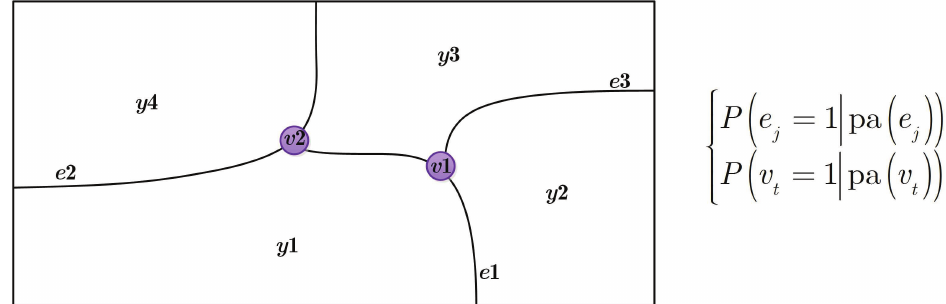
Figure 6. The causalities among regions, edges and vertices. An edge is formed by the intersection of the regions with different labels, and these regions are the parent nodes of the edge. The vertex is formed by edges, and these associated edges are the parent nodes of the